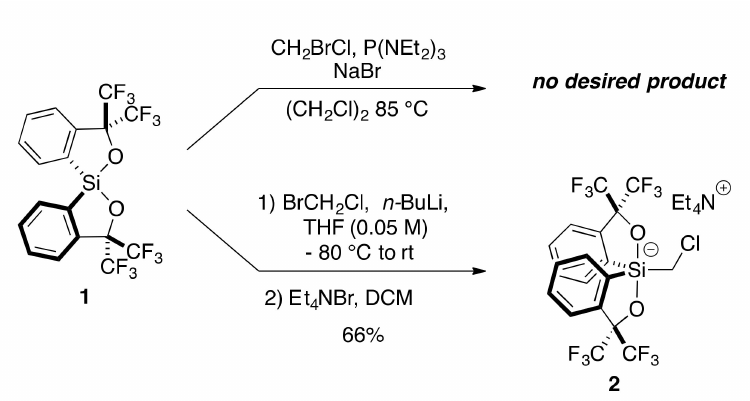
Scheme 1. Synthesis of chloromethylsilicate 2 .